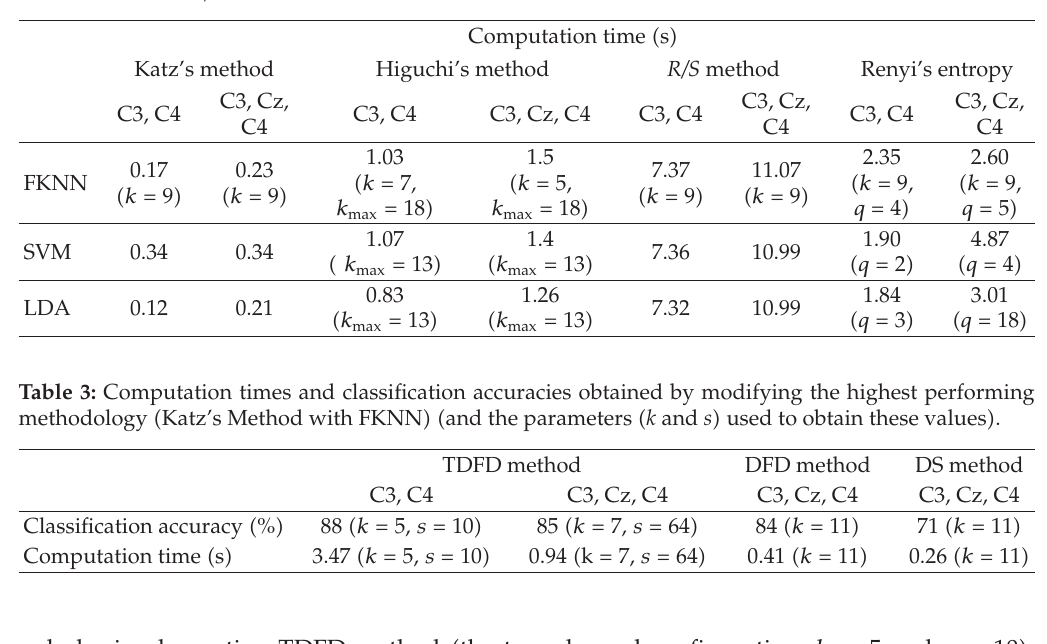
Table 2: Computation times (cid:4) time it took for feature extraction and classification (cid:5) corresponding to the maximum classification accuracies obtained by the combination of fractal dimension estimation methods and classifiers with the two and three electrode configurations (cid:4) and the parameters (cid:4) k and k max (cid:5) used to obtain these values (cid:5) .